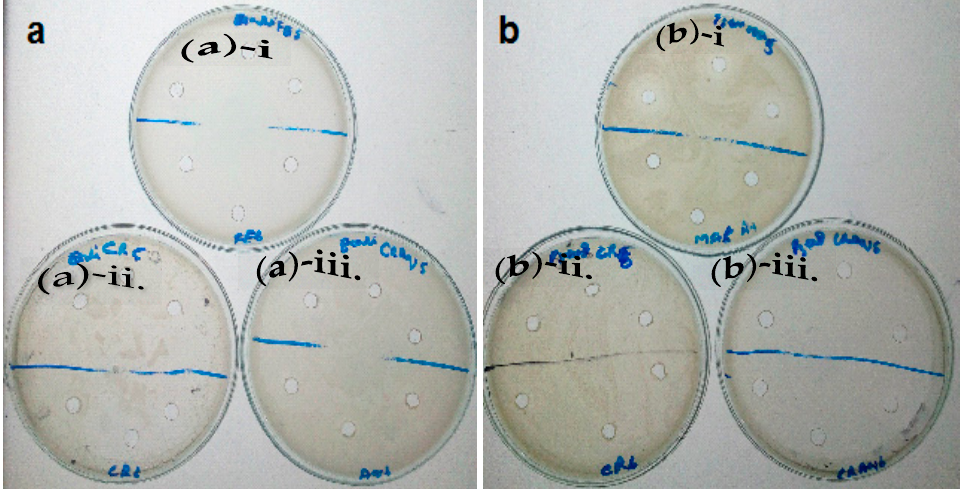
Figure 6. ( a ) -i . Antibacterial activity of AgNPs with E. coli ; ( a ) -ii. Antibacterial activity of aq. extract with E. coli ; ( a ) -iii. Antibacterial activity of MeOH extract with E. coli ; ( b ) -i. Antibacterial activity of AgNPs with P. aeruginosa ; ( b ) -ii. Antibacterial activity of aq. extract with P. aeruginosa ; ( b ) -iii. Anti- bacterial activity of MeOH extract with P. aeruginosa.